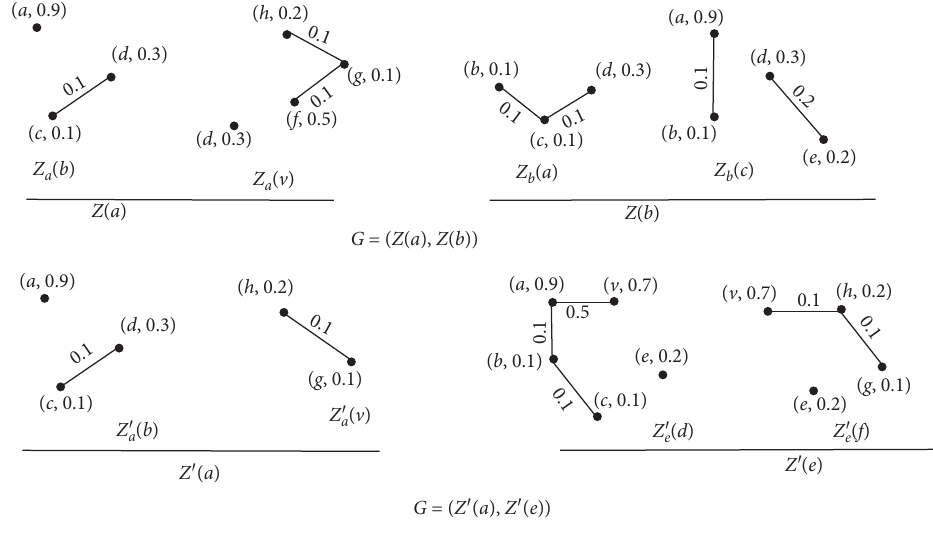
Figure 19: G � ( Z ( a ) ,Z ( b )) and G ′ � ( Z ′ ( e ) , Z ′ ( a )) .